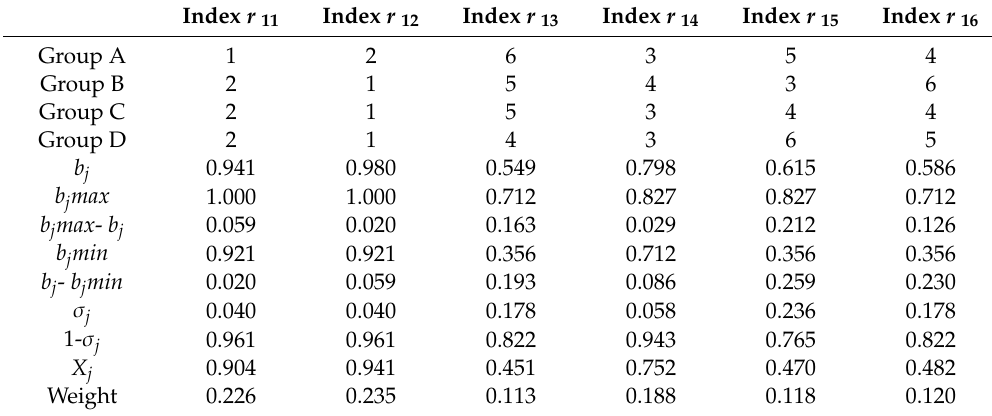
Table A2. Weight distribution of the second grade indexes of r 1.